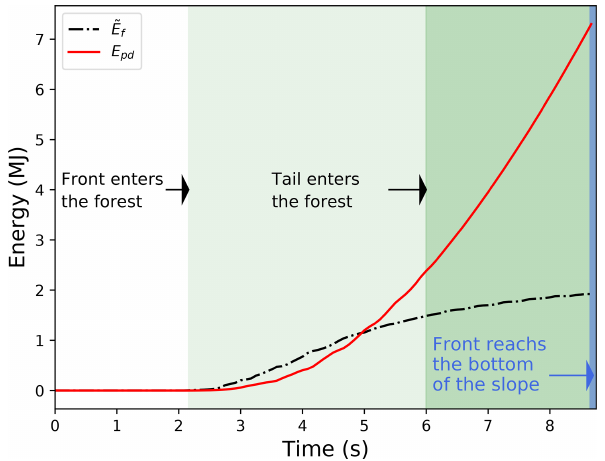
Figure 12. Temporal evolution of the detrainment energy and dissi- pation due to the forest (Case 2, v 0 = 6ms − 1